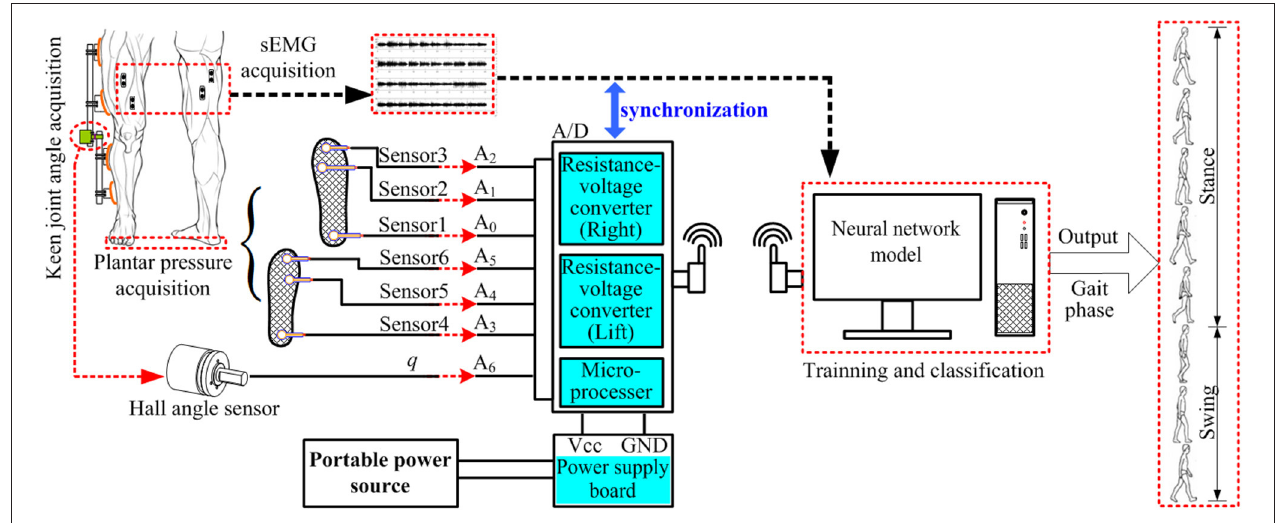
FIGURE 1 | Structure of gait phase classification system.